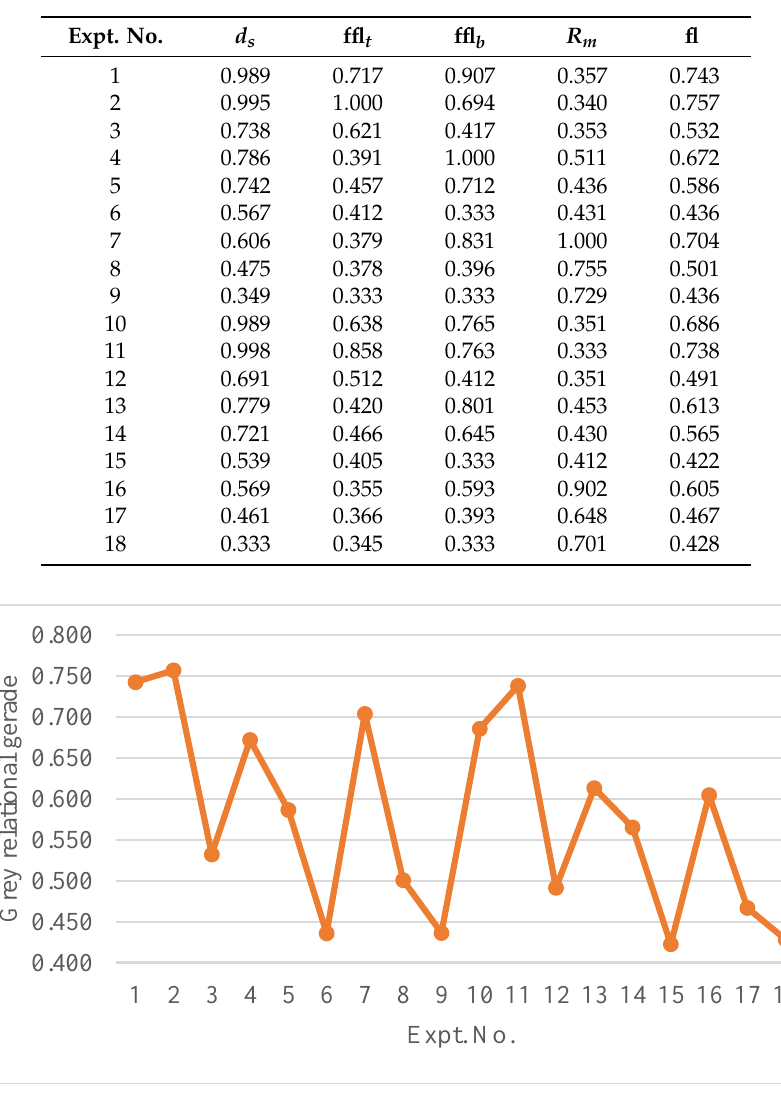
Figure 16. Experiments evaluation according to grey relational grade.